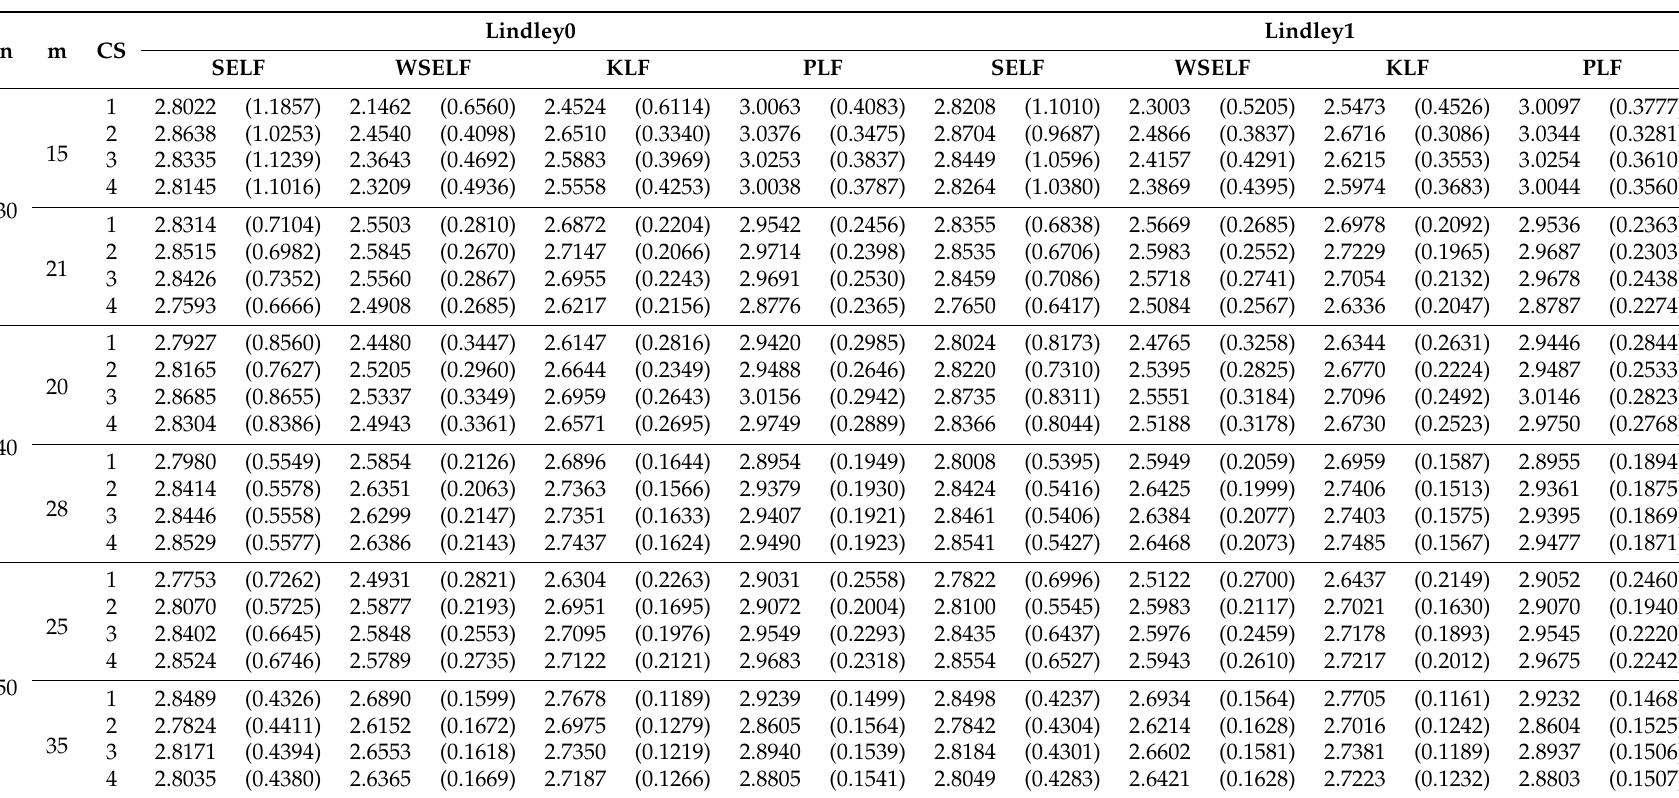
Table 3. Bayesian estimates and corresponding posterior risks (PRs) (in brackets) of entropy for Burr XII distribution with α = 0.8 and β = 0.8 under different censoring schemes and loss functions using the Lindley method. The hyperparemeters for gamma prior are a = 0.8, b = 1, c = 0.8 and d = 1. The true value of entropy is